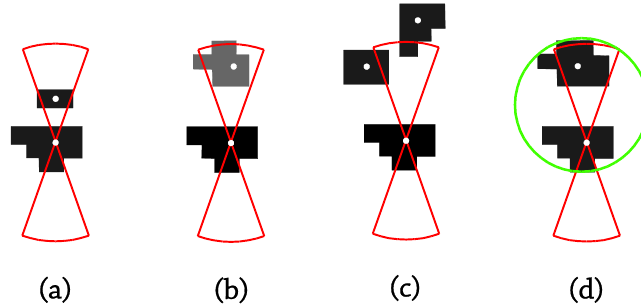
Figure 6. Discarding criteria in front projection. The double red cone, whose angle and height depend on the size of the selected region, indicates the valid area for the twin bright region centroid. Regions in ( a – c ), remain unpaired, as they do not fulfil all of the criteria. Bubble outline: Bubble